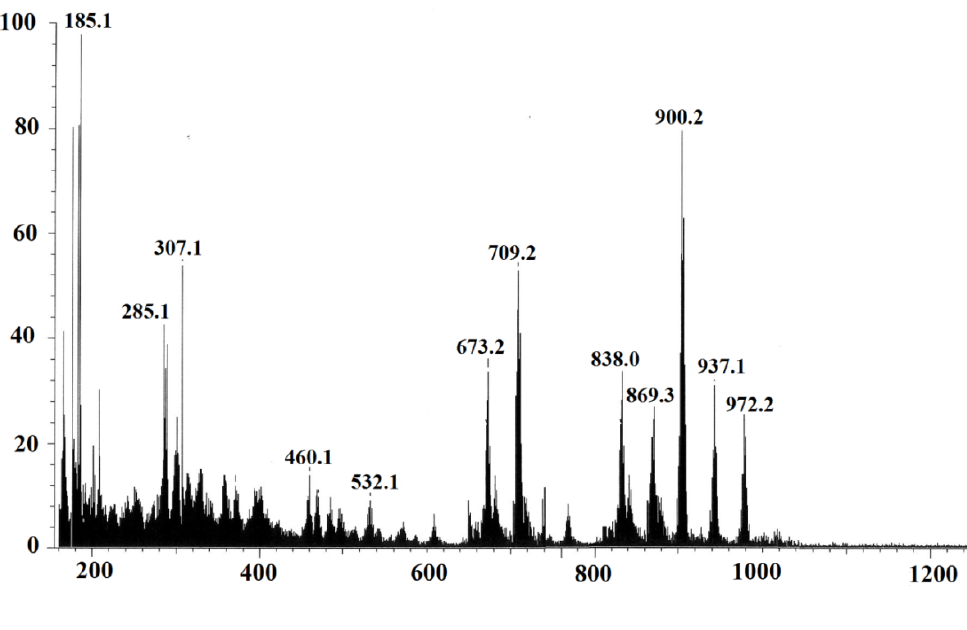
Figure 2. FAB-MS spectrum of complex 1